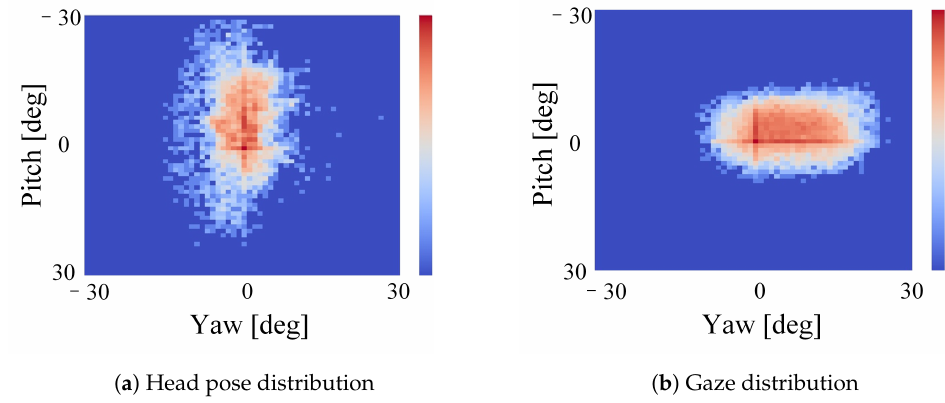
Figure 5. Distribution of head pose and gaze direction of the collected